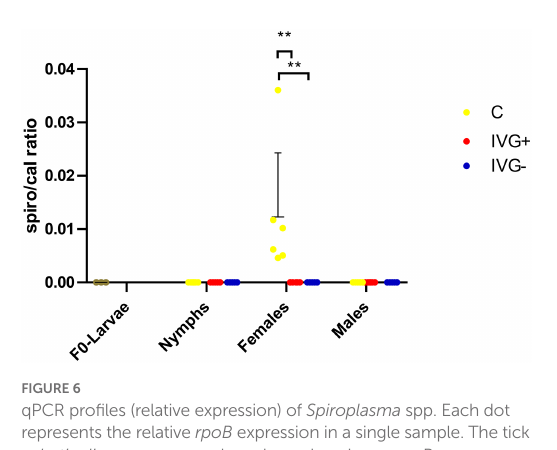
FIGURE 5 qPCR profiles (relative expression) of Rickettsia helvetica . Each dot represents the relative gltA expression in a single sample. The tick calreticulin gene was used as a housekeeping gene. Bars represent mean with the standard deviation shown in error bars. Statistical analysis by Mann–Whitney test performed in Graphpad. IVG + , in vitro feeding with gentamicin; IVG − , in vitro feeding without gentamicin; C, control feeding in vivo on calves. * p < 0.05, ** p < 0.01.